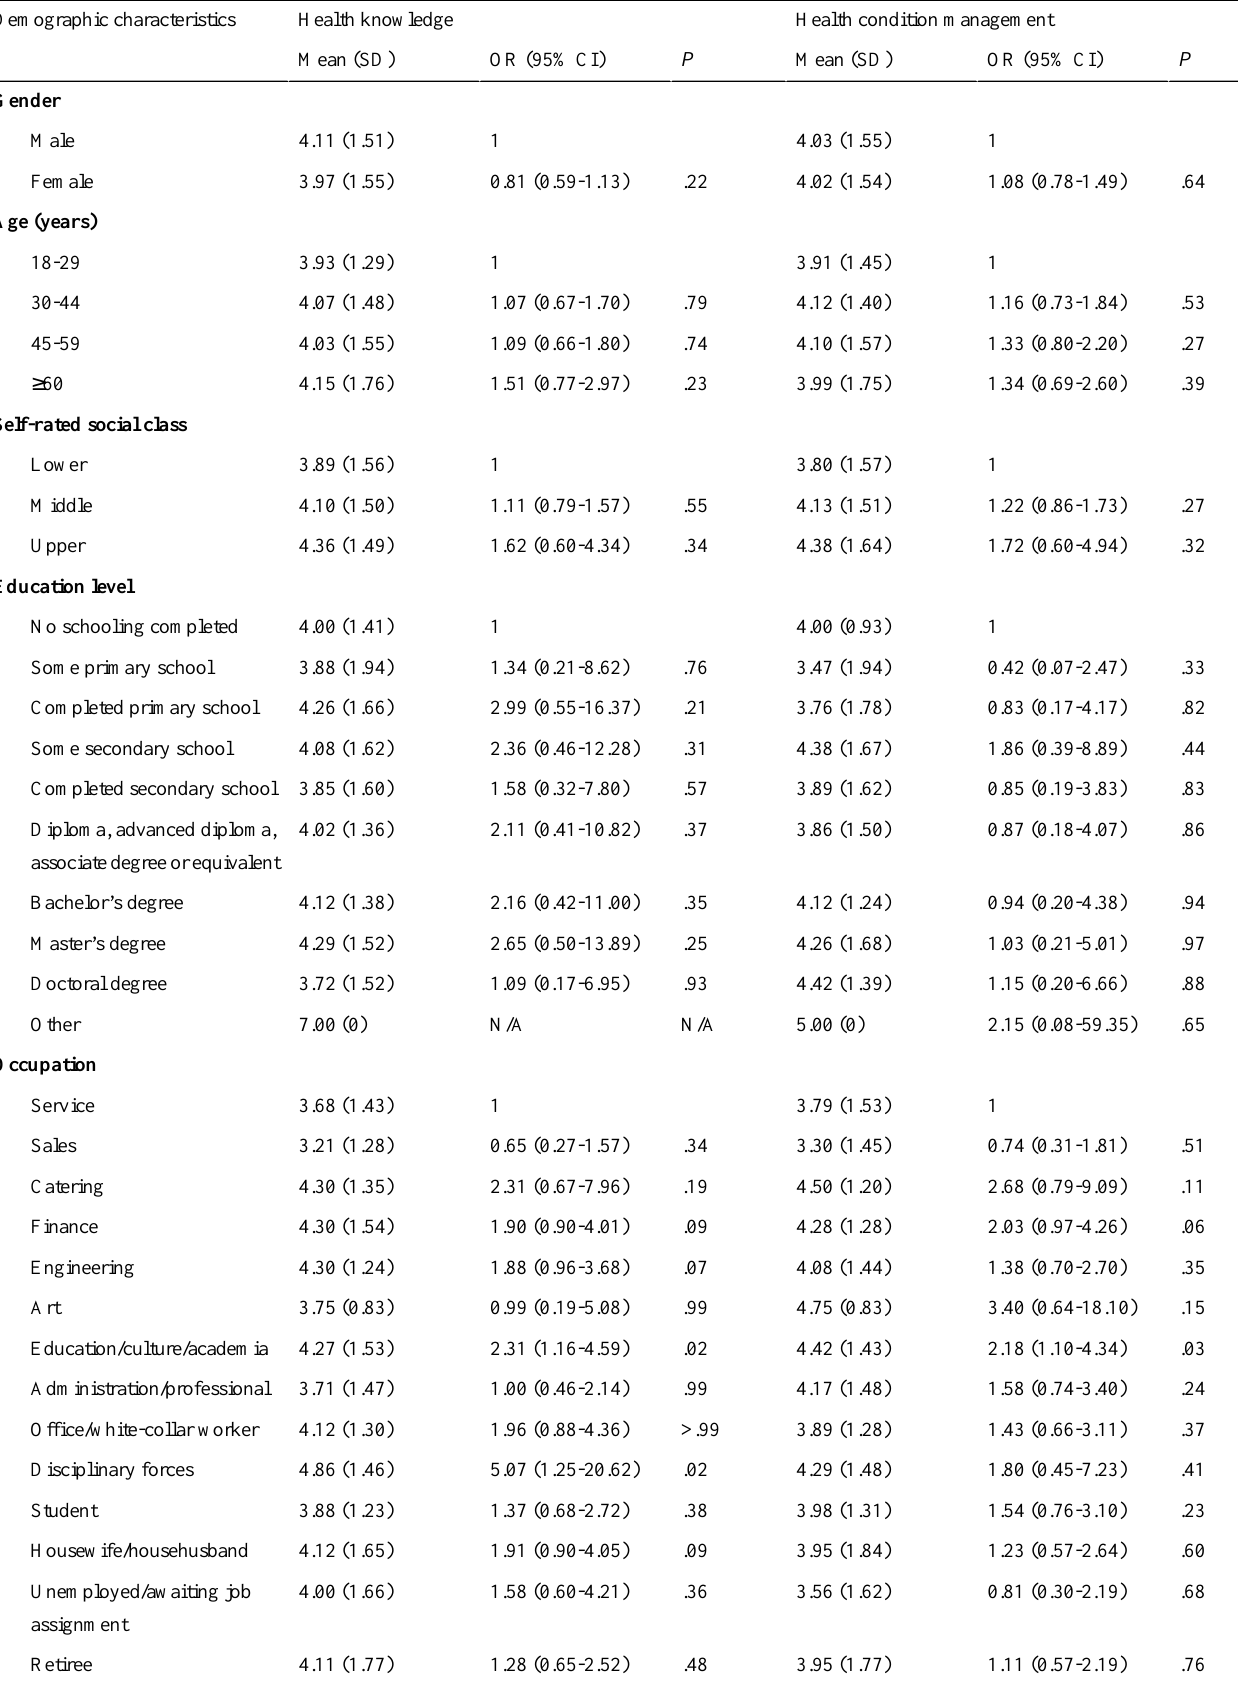
Table 4. Means and standard deviations of perceived impacts of health app use on increased health knowledge and improved health condition management, and demographic correlates (N=633). N/A: not applicable; OR: odds